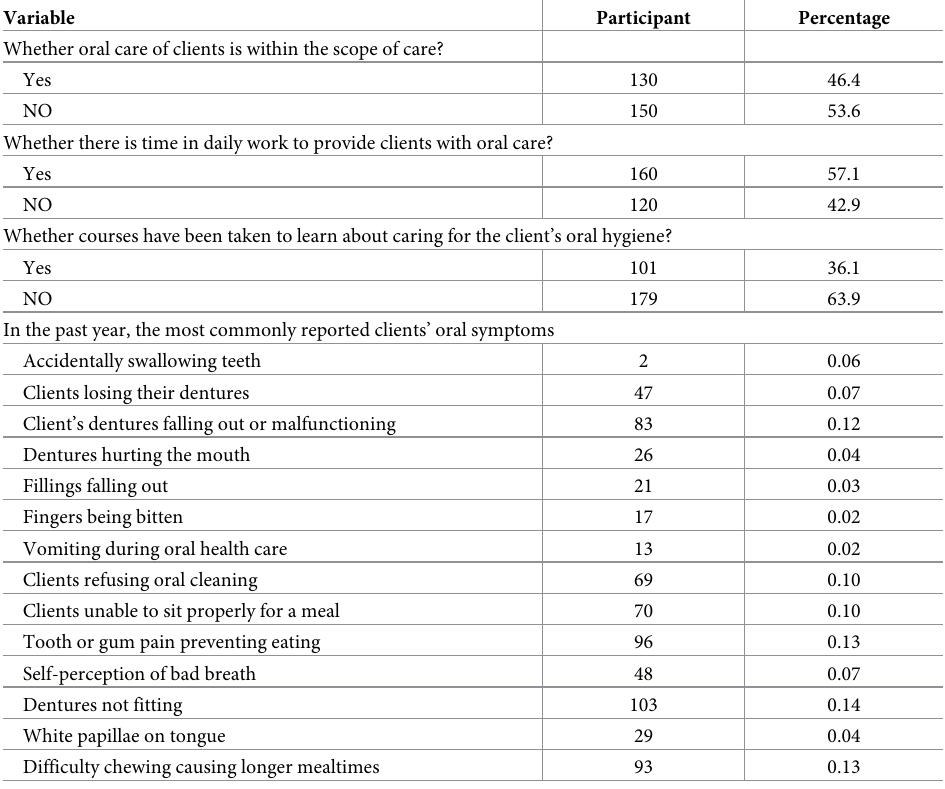
Table 2. HCAs understanding of clients’ oral health care